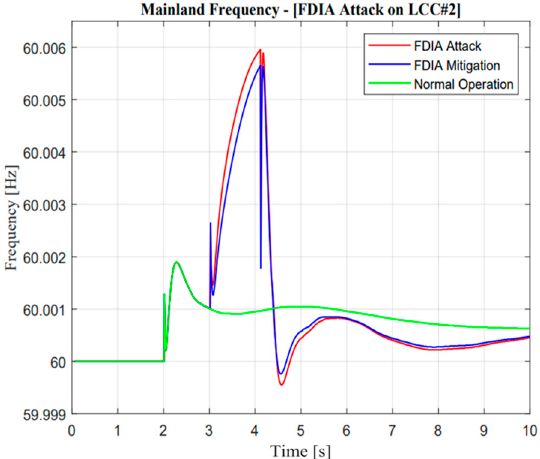
Figure 29. Mainland frequency in the false data injection attack operation.